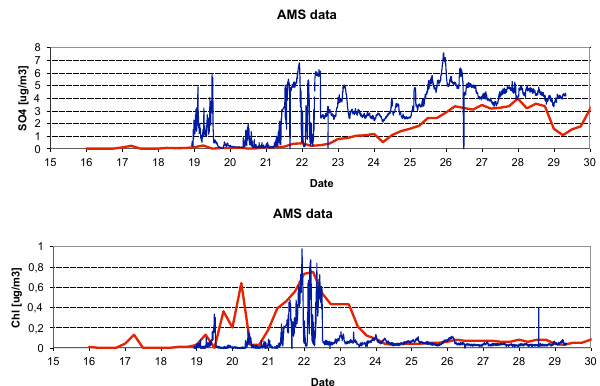
Fig. 3. AMS-measured (dark blue line) and modelled (red line) near-surface aerosol mass concentration during June 2010 at Puy- de-Dôme, France. (a) Sulfate [µgm − 3 ], (b) chloride [µgm − 3 ].